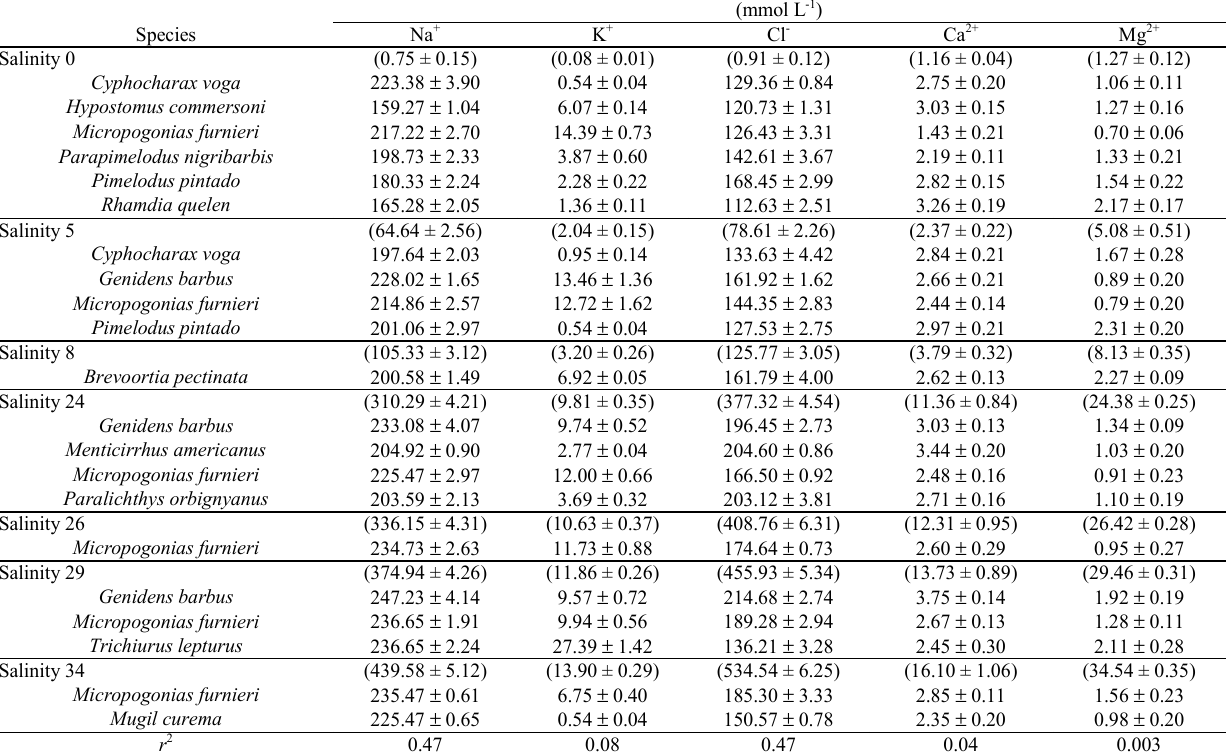
Table 2. Plasma ion levels of teleosts collected from water at different salinities from the São Gonçalo channel. Values in parentheses represent water ion levels. Values are presented as the means ± SEM (n = 12); r 2 is related to the salinity x plasma ion level